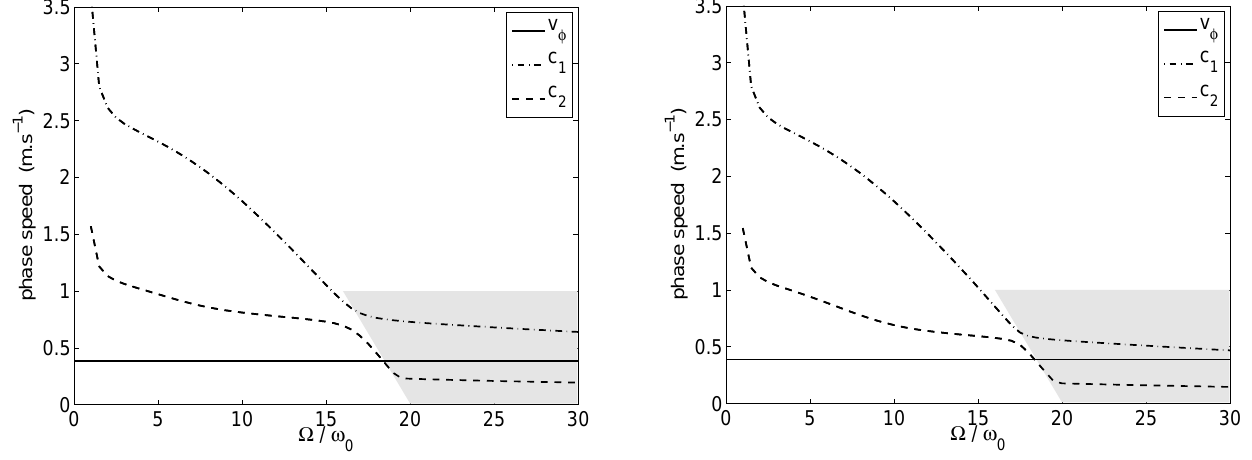
Fig. 5. Phase speeds of the two first internal modes versus their frequency for stratification S1 and comparison with the horizontal phase speed of the ITB. The “trapped regime” is the grey-shaded area (adapted from GSG10).